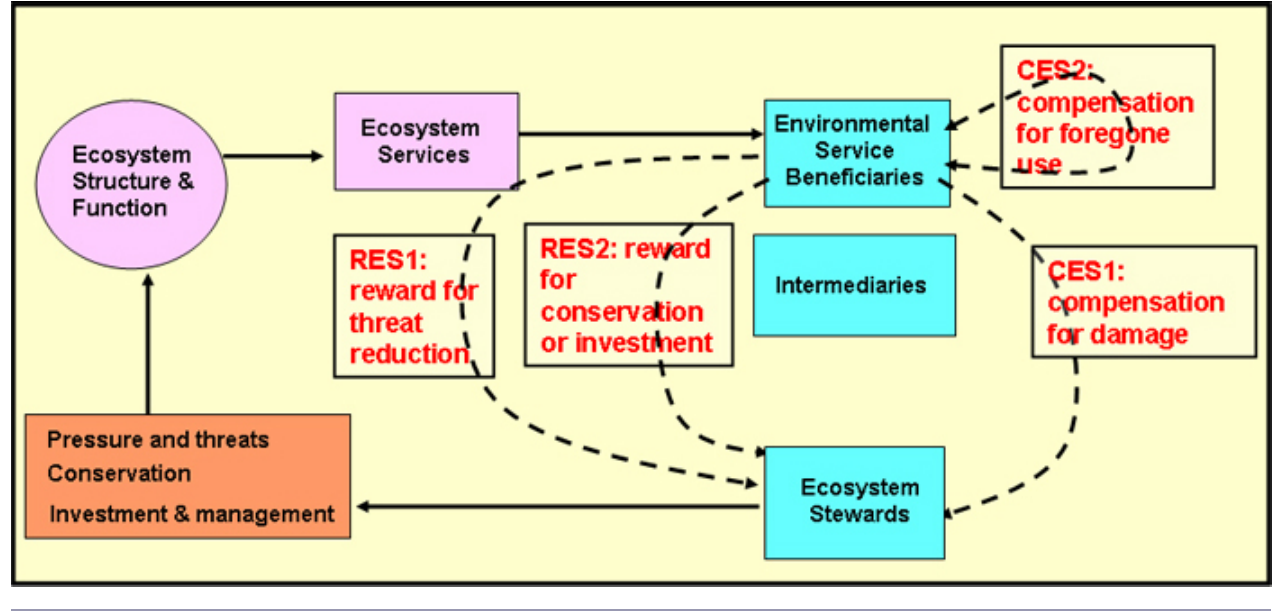
Fig. 1. Characterization of mechanisms for compensation and reward for environmental